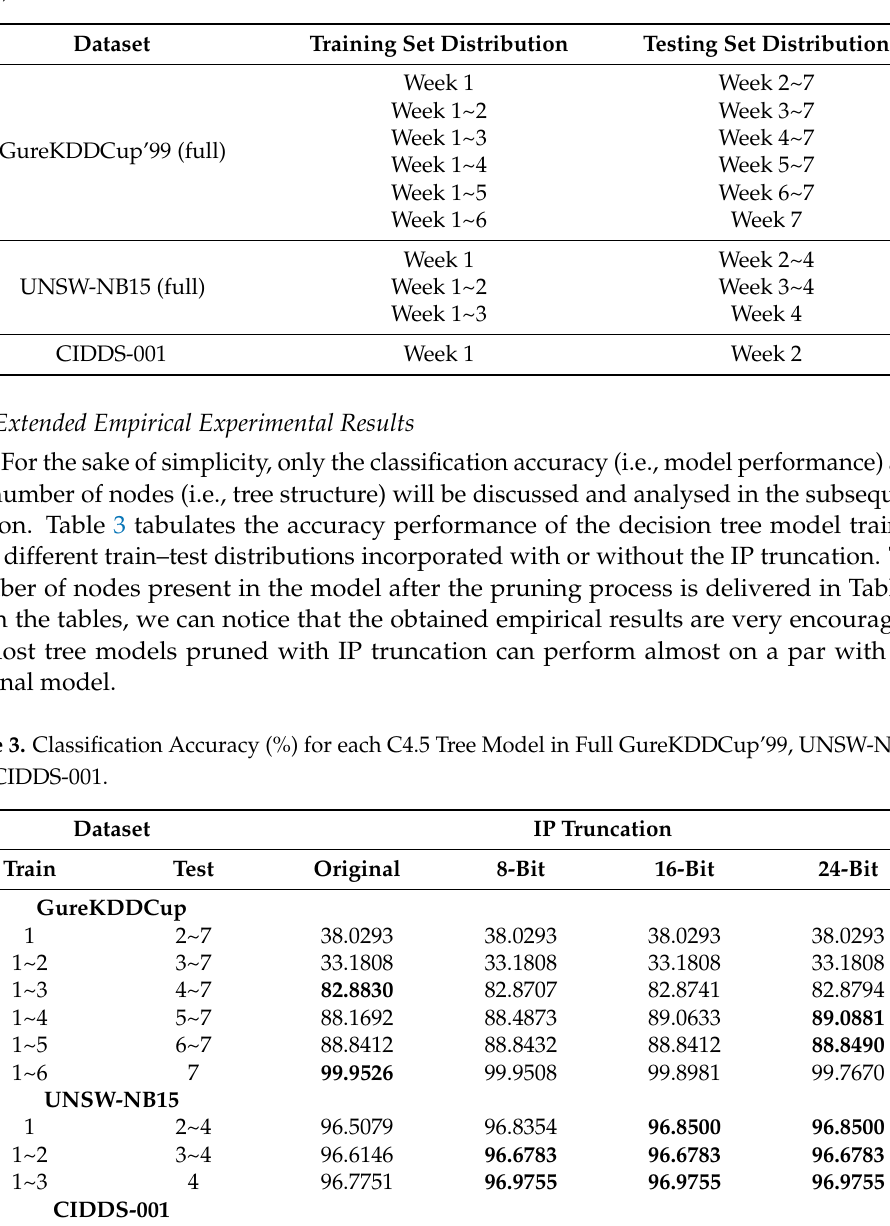
Table 2. Distribution of Training and Testing Sets for the full version of GureKDDCup’99, UNSW- NB15, and CIDDS-001.